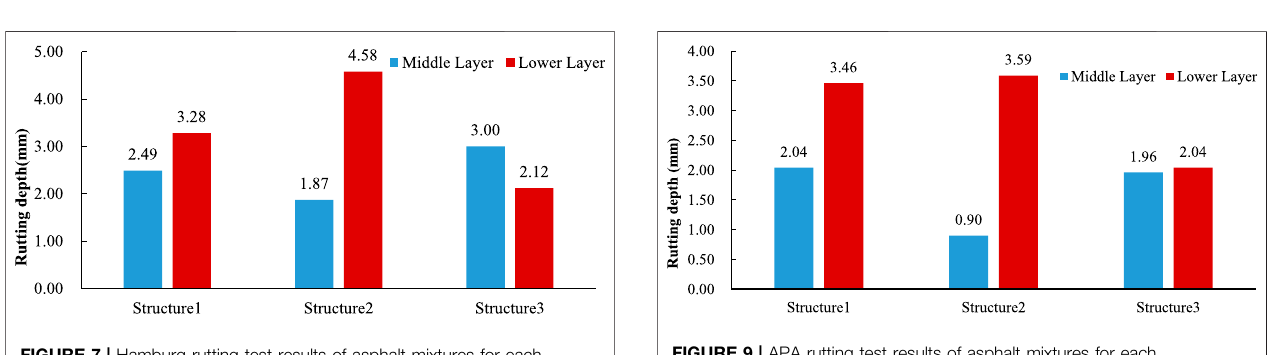
FIGURE 7 | Hamburg rutting test results of asphalt mixtures for each pavement structure.